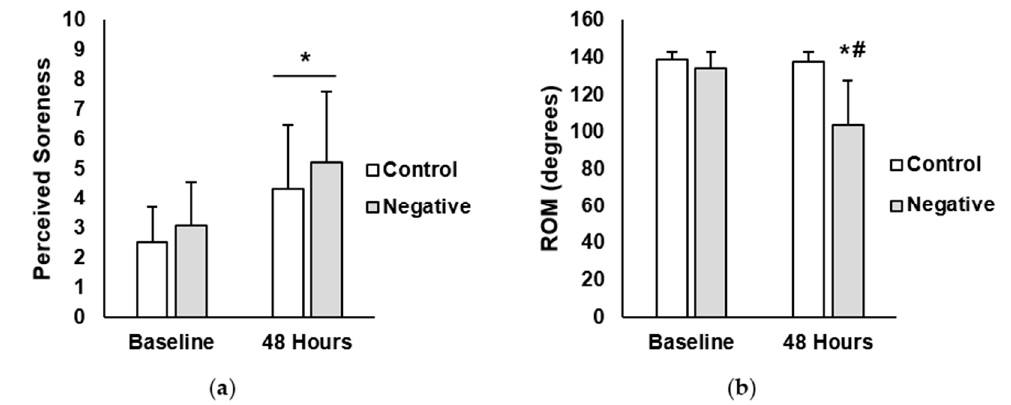
Figure 1. ( a ) Perceived muscle soreness in the control and negative-belief (negative) groups at baseline and 48 h after the soreness exercise protocol. ( b ) Range of motion (ROM) in control and negative-belief (negative) groups at baseline and 48 h after the soreness exercise protocol. Data are presented as mean ± SD. * indicates significantly different from baseline, # indicates significantly different from control ( p < 0.05).